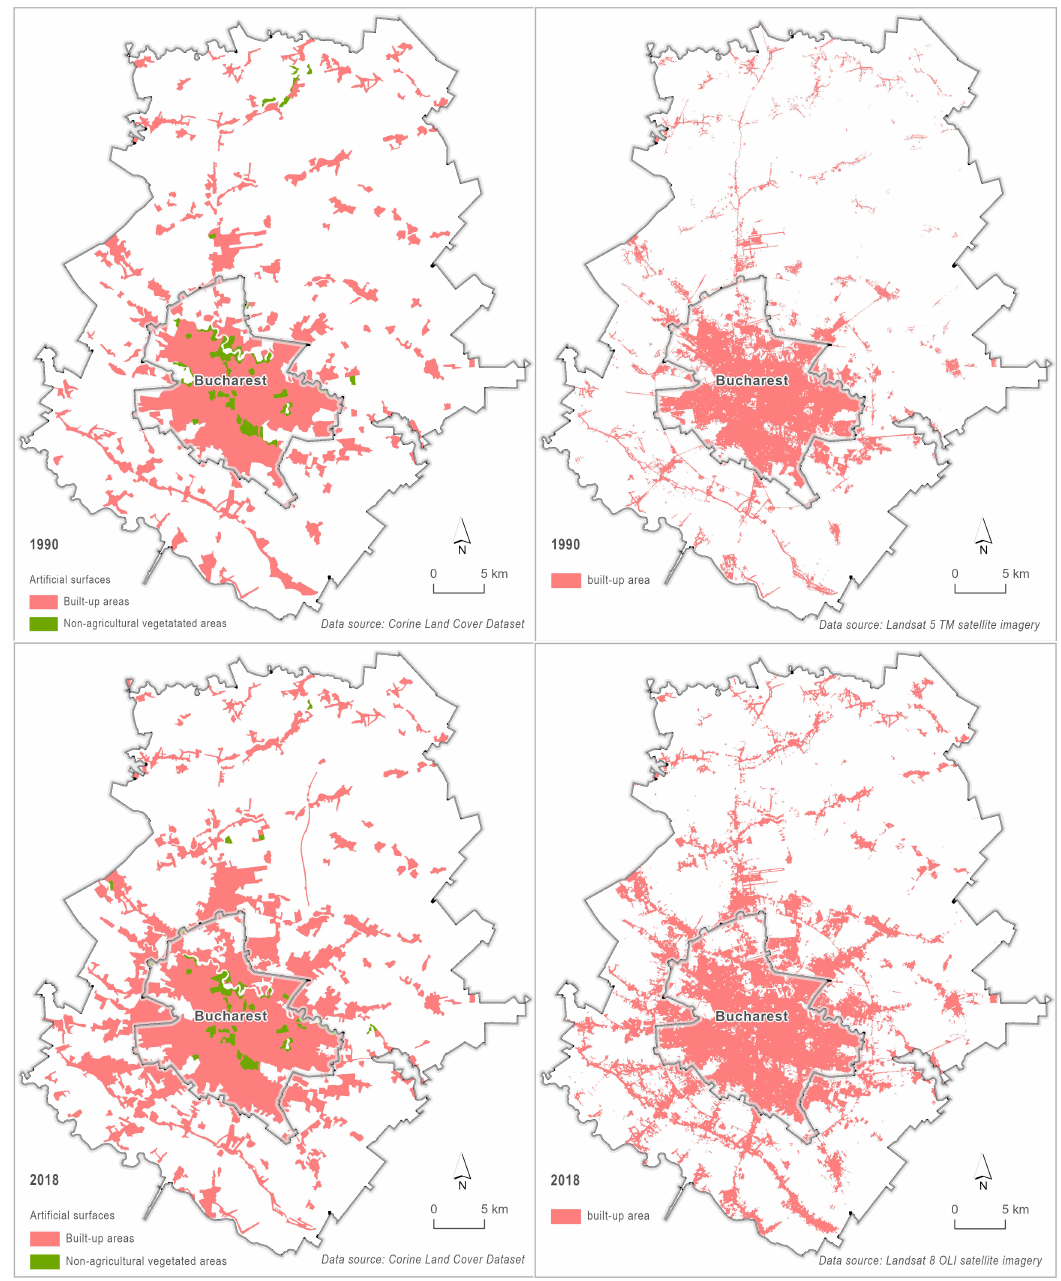
Figure 3. Built-up area in the Bucharest–Ilfov Region reflected by CLC datasets ( left ) and automatically generated from Landsat datasets ( right ) for 1990 and 2018 time